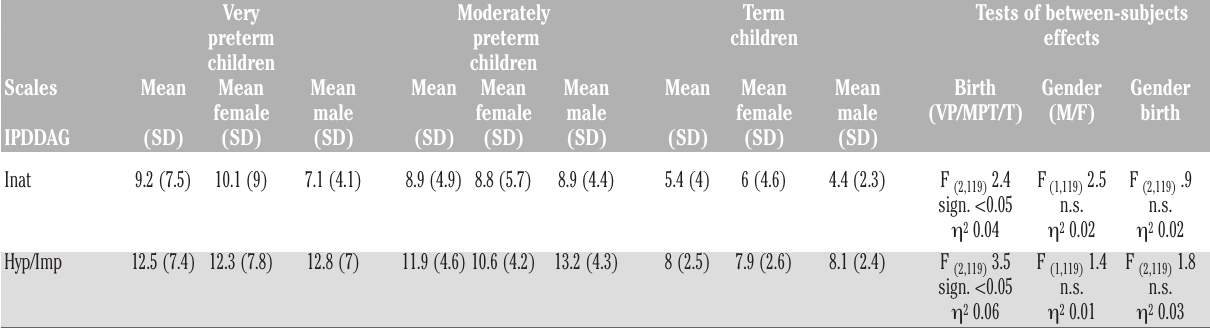
Table 2. Precursors of attention deficit and hyperactivity/impulsivity in research group. Very Moderately Term Tests of between-subjects preterm